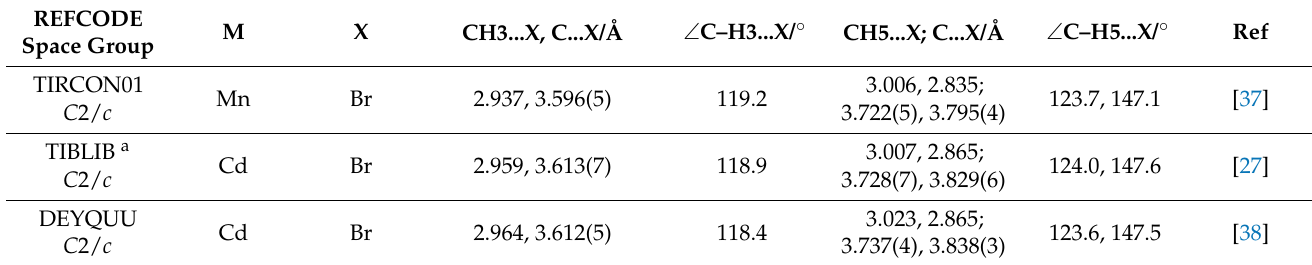
Table 5. Metric parameters for CH...X contacts in the group of non-solvated cis- [M(bpy) 2 X 2 ] (Figure 6). H3 and H5 in the columns headings refer to bpy H